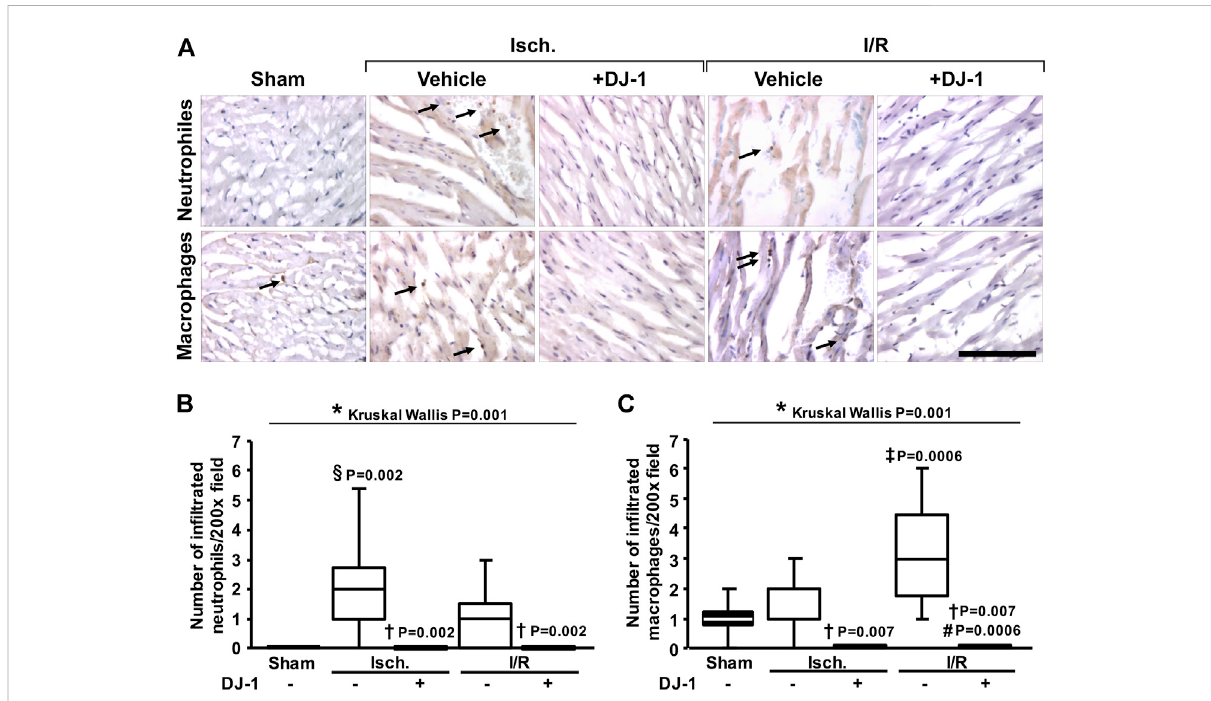
Effects of DJ-1 systemic administration on myocardial leukocyte in fi ltration after ischemia and ischemia/reperfusion. (A) . Representative immunohistochemicalacquisitionsofmyocardialneutrophils(upperpanel)andmacrophages(lowerpanel)afterischemiaandischemia/reperfusion inthepresenceand theabsence of asystemic administration ofDJ-1. A sham-operatedgroup was included as baseline. (B) and (C) quanti fi cation of in fi ltratedleukocytes.Scalebar:100 µm;* p < 0.05,Kruskal-Wallis;§ p < 0.05vs.sham, † p < 0.05vs.ischemiawithoutDJ-1, ‡ p <